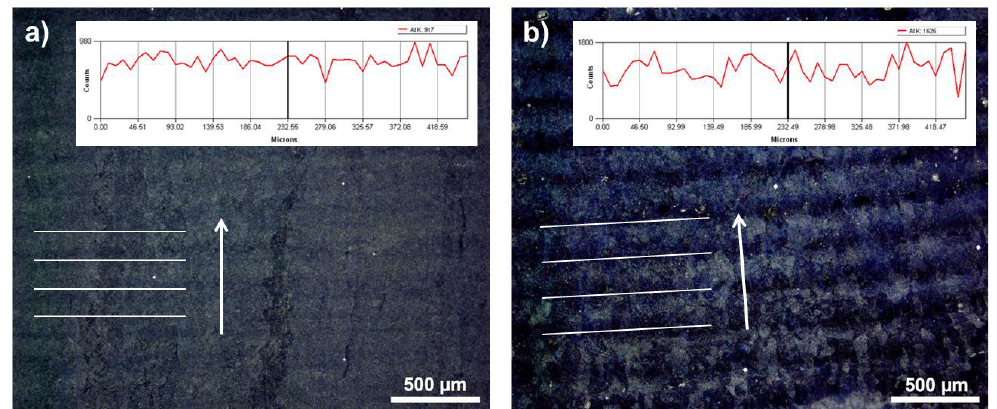
Figure 6. EDS results showing aluminum content along building direction in ( a ) EBM- and ( b ) SLM-fabricated samples.